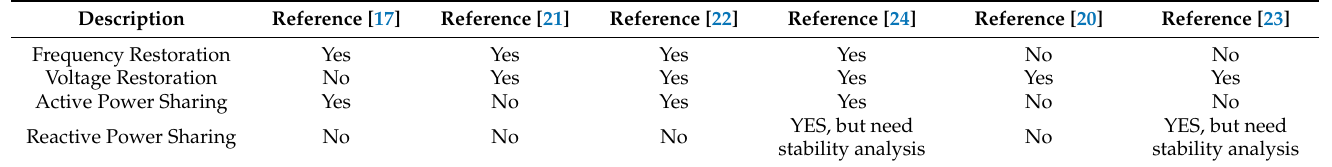
Table 1. The comparison of the distributed finite-time control in recent